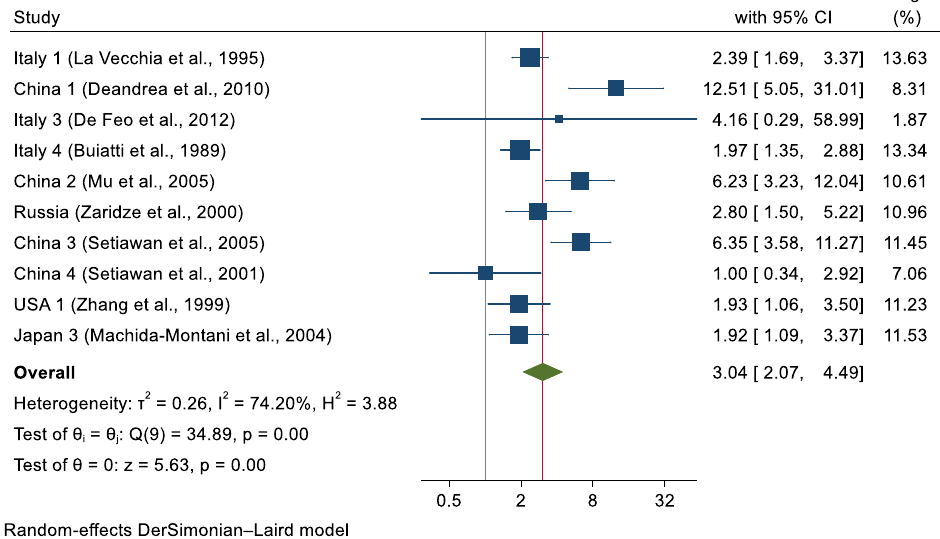
Figure 1. Study-specific and Pooled ORs for the Overall Association Between History of Gastric Ulcer and Gastric Cancer.